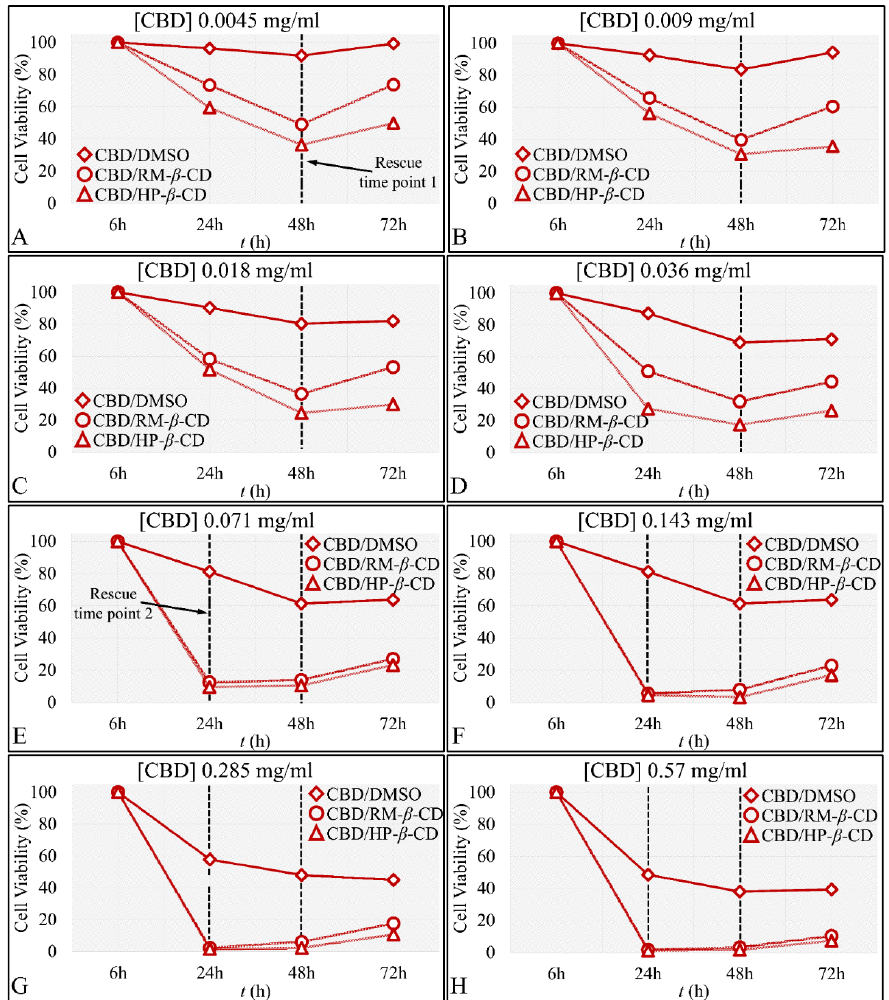
Figure 13. Comparative time-dependent effect of CBD and CBD inclusion complexes on TE671 cells. The 0.0045 mg/mL ( A ), 0.009 mg/mL ( B ), 0.018 mg/mL ( C ), 0.036 mg/mL ( D ), 0.071 mg/mL ( E ), 0.143 mg/mL ( F ), 0.285 mg/mL ( G ), and 0.57 mg/mL ( H ) concentrations are presented. The most effective inclusion complexes were the CBD/HP- β -CD and CBD/RM- β -CD for all concentrations, and between the 24 and 72 h cytotoxicity ( p < 0.001), followed by CBD/DMSO. Each value represents the mean ± SD of triplicate experiments.